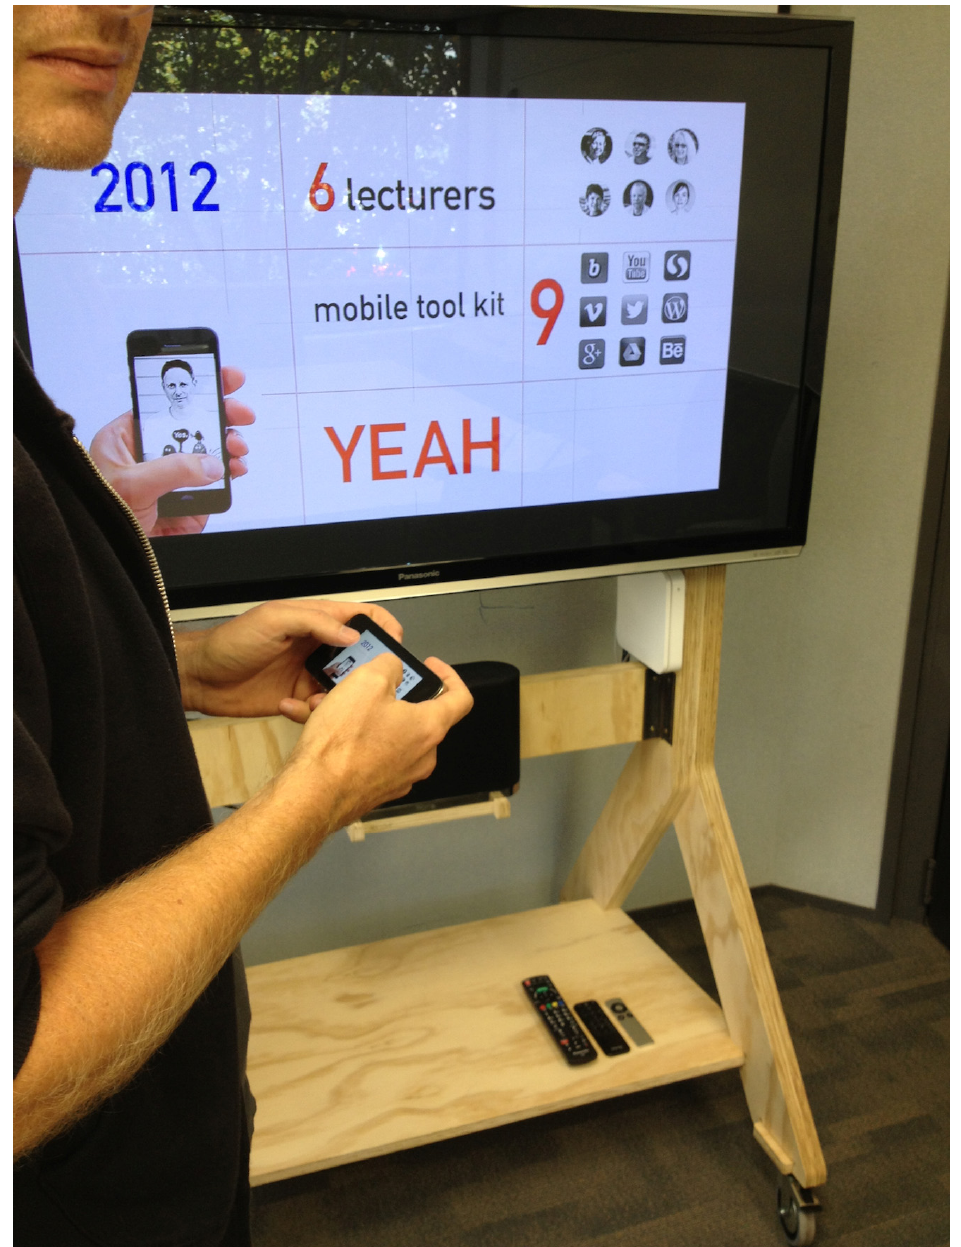
Figure 1. Mobile Airplay Screen (MOAs)